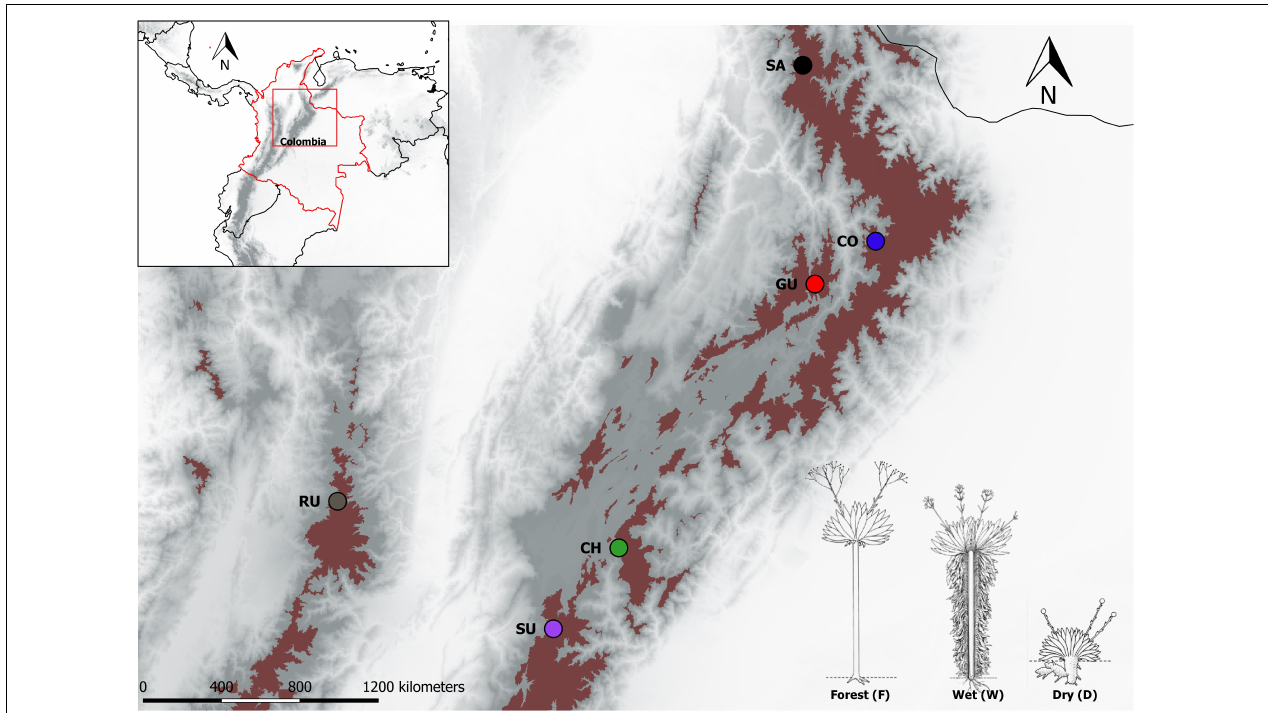
FIGURE 1 | Páramo localities in the northern Andes sampled in this study. Red shaded areas mark the 2013 Páramo delimitation in the Colombian Andes as taken from http://paramo.uniandes.edu.co/. Localities are identified by different colors and abbreviated as follows: Chingaza (CH), Cocuy (CO), Guantiva (GU), Santurbán (SA), Sumapaz (SU), and Ruíz (RU). In the bottom right, a schematic drawing of the different ecotypes according to Cuatrecasas (2013), are coded as follows: caulescent populations from the cloud forest (F), caulescent populations from wind-sheltered well-irrigated depressions (W) and acaulescent populations from wind-exposed drier slopes